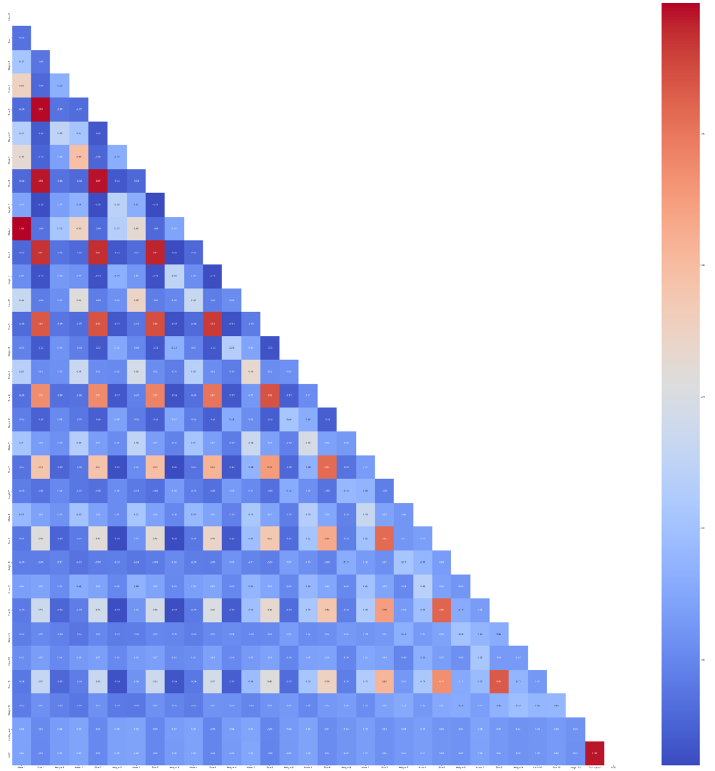
Figure 19. The correlation matrix (single multiplex profiles).